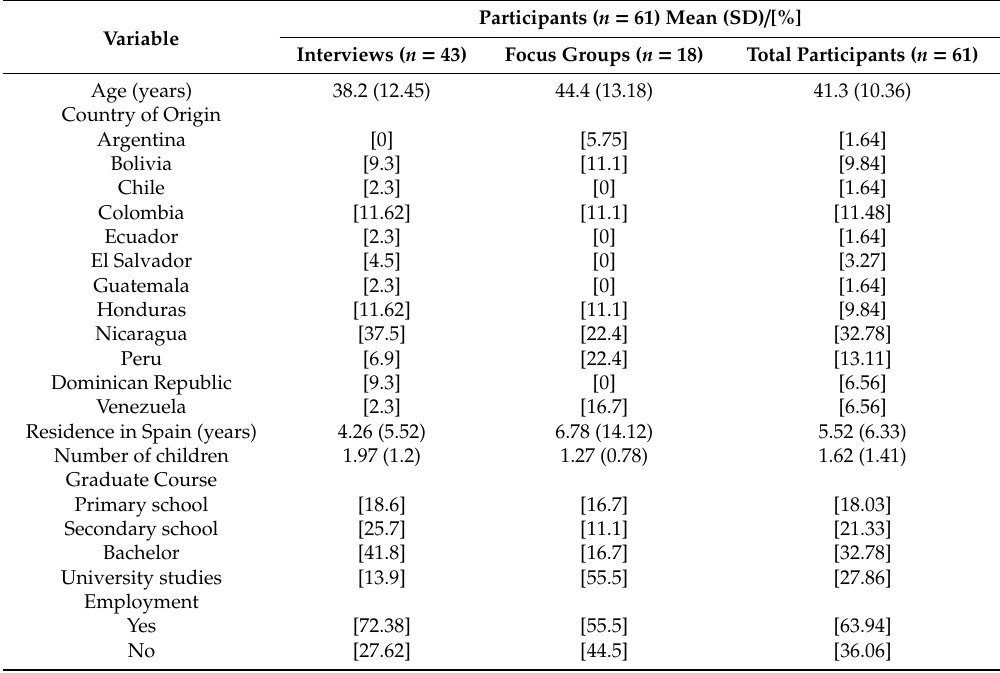
Table 2. Sociodemographic characteristics and employment